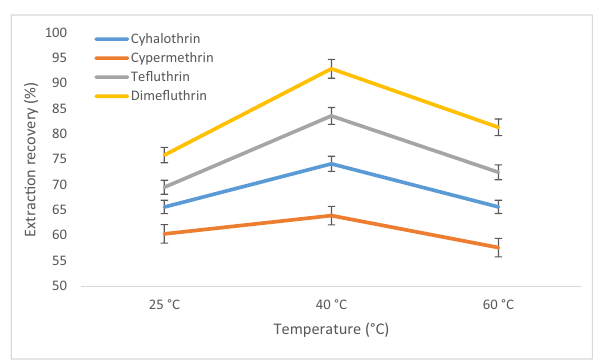
Figure 4: E ff ect of temperature on the e ffi ciency of extraction ( ex - traction conditions: 100µL of 100ngL − 1 of each analyte; extraction time: 180min; stirring speed: 700rpm; sample volume: 20mL; pH: 7 ) .